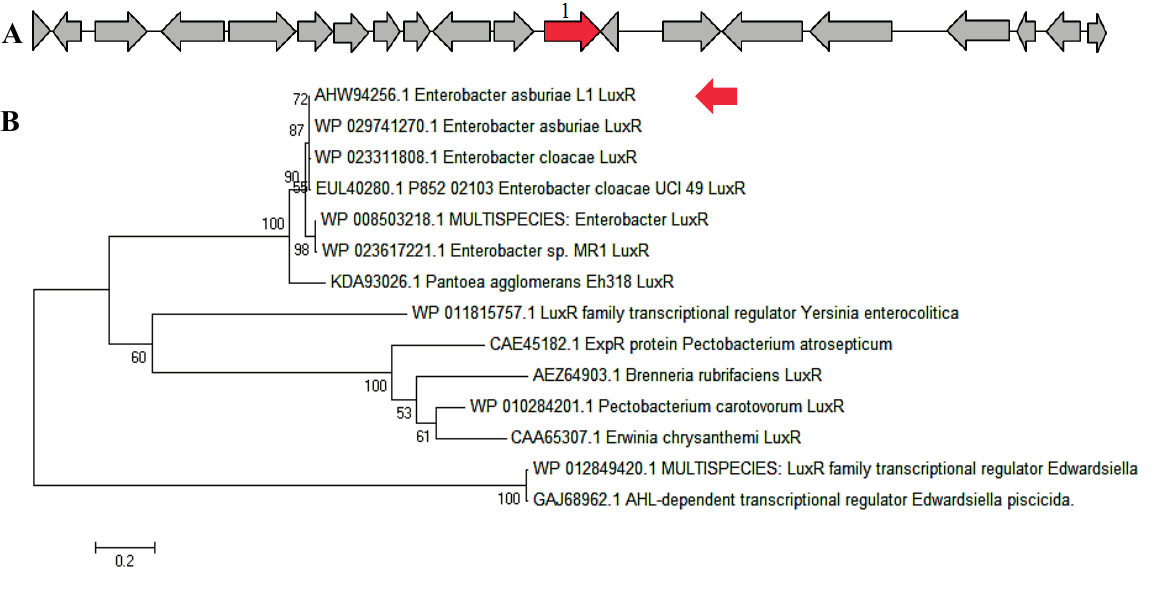
Figure 5. Putative luxR gene of E. asburiae L1. ( A ) The red arrow showed the visual region of E. asburiae L1 luxR gene and ( B ) Phylogenetic analysis of E. asburiae L1 luxR gene. The tree was constructed based on the LuxR protein sequences by Neighbor-Joining with bootstraps value of 1000